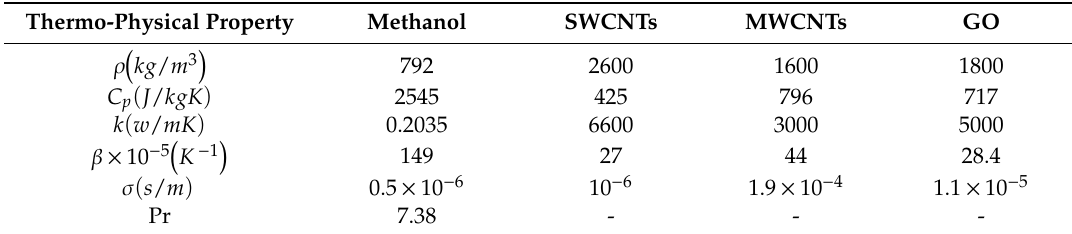
Table 3. Thermo-physical properties of nanoparticles and methanol [45,50,51]. Thermo-Physical Property